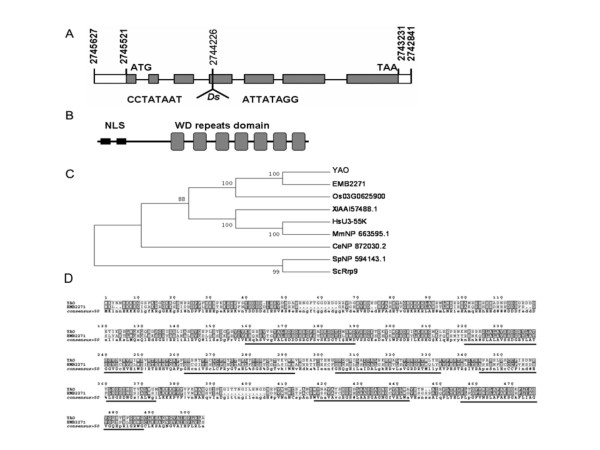
Molecular characterization of the YAO. (A) Diagram of the Ds insertion in YAO. The grey boxes indicate the exons of YAO, the white boxes indicate the UTR regions and the lines indicate the intron regions. The nucleotide numbers are consistent with those in the Arabidopsis genome on TAIR web site. (B) Diagram of predicated domain structure of YAO protein. NLS, nuclear localization signal. (C) Phylogenetic tree of YAO with its homologs from other organisms: EMB2271 from A. thaliana; Os03G0625900 from O. sativa; HsU3-55K from H. sapiens; MmNP_663595.1 from M. musculus; XlAAI57488.1 from X. laevis; CeNP_872030.2 from C. elegans; SpNP_594143.1 from S. pombe; ScRrp9, from S. cerevisiae. (D) Protein alignment of YAO and EMB2271. The seven predicted WD40-repeat domains are underlined.